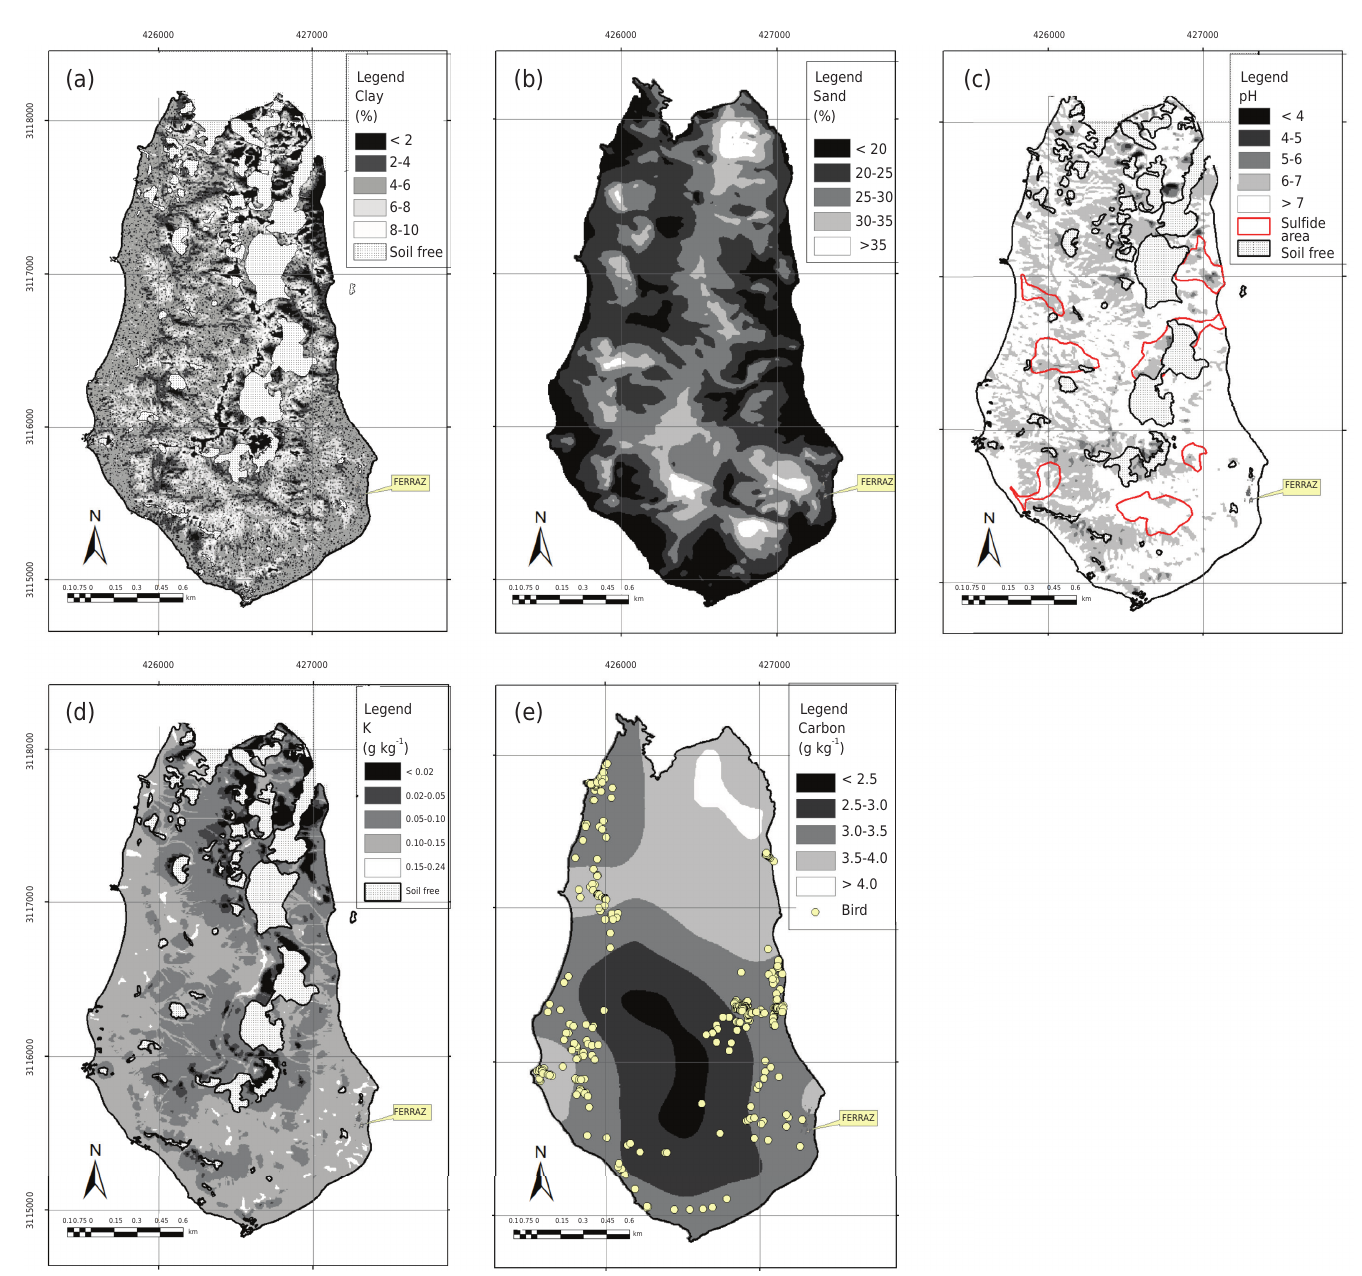
Figure 4. Thematic maps of clay (a), sand (b), pH (c), potassium (d), and soil organic carbon (e) estimated in Keller